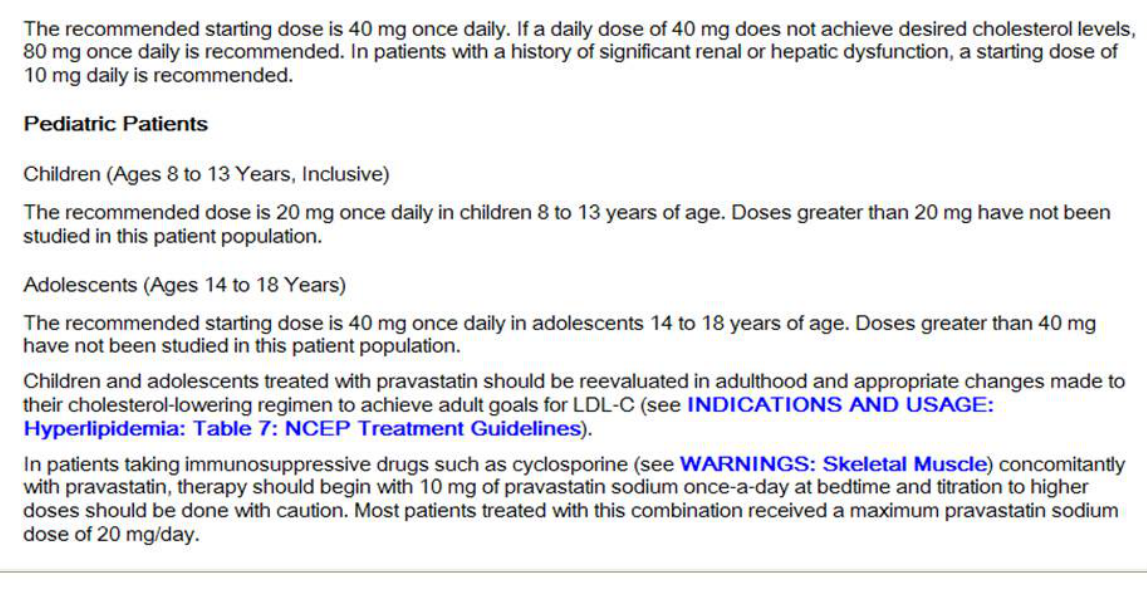
Figure 3. DailyMed entry for pravastatin